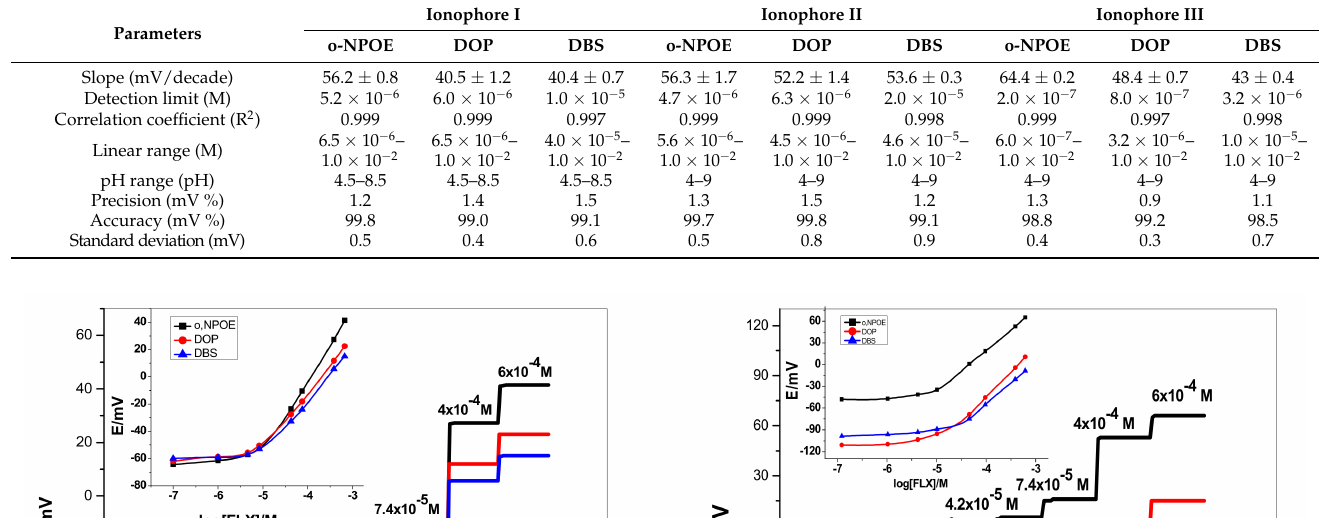
Table 2. Potentiometric response characteristic of FLX sensors in 10 mM Tris buffer, pH 7.